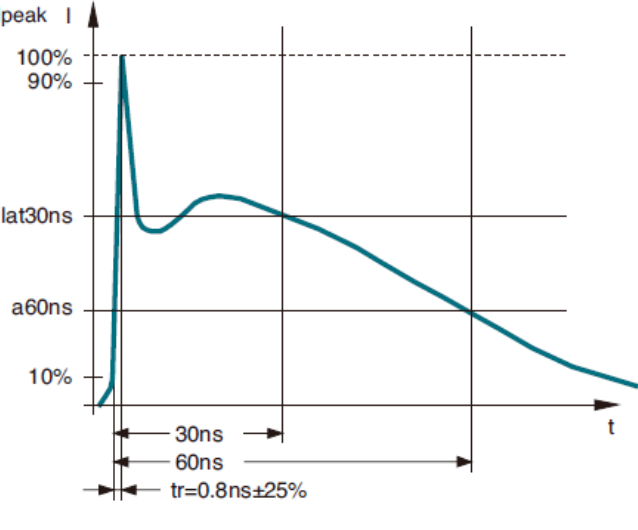
Figure 4. Current pulse waveform of ESD generator.